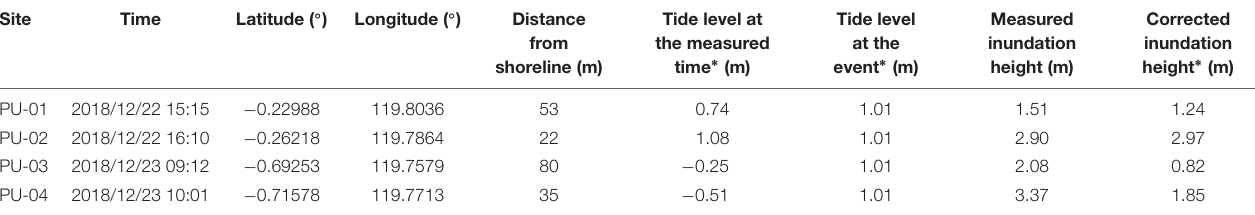
FIGURE 5 | Large-scale landslide at Balaroa: (A) Google Earth image before the earthquake, (B) Google Earth image after the earthquake, and (C) view from the crown area of the mudflow. TABLE 1 | Tsunami inundation and run-up height measurements at four locations along Palu Bay.